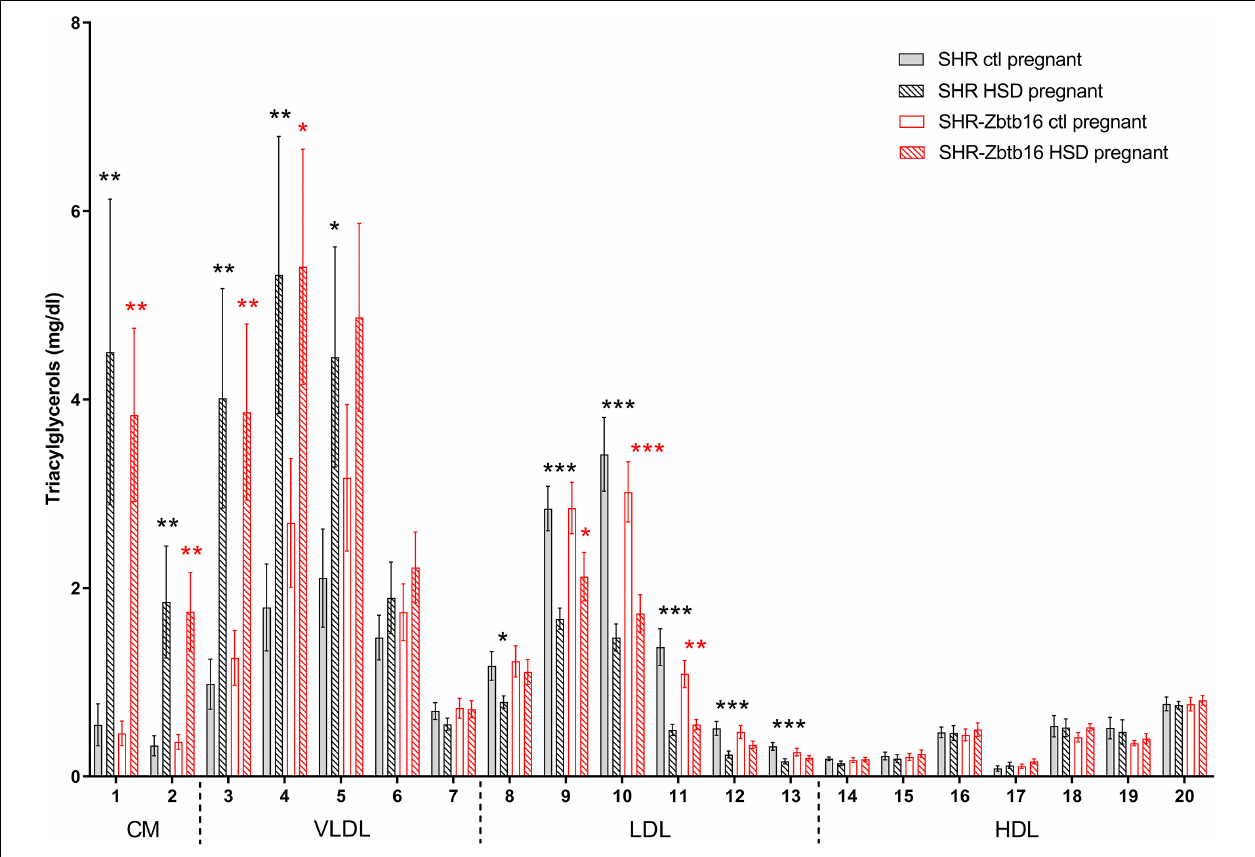
FIGURE 4 | Triacylglycerol profile. The triacylglycerol (Tg) content in 20 lipoprotein subfractions in pregnant SHR female rats and SHR- Zbtb16 female rats – SHR fed standard diet in pregnancy (SHR ctl pregnant – light gray bars), SHR fed HSD in pregnancy (SHR HSD pregnant – black patterned bars), SHR- Zbtb16 fed standard diet in pregnancy (SHR- Zbtb16 ctl pregnant – open red bars) and SHR- Zbtb16 fed HSD in pregnancy (SHR- Zbtb16 HSD pregnant – patterned red bars). Tg profile before pregnancy is shown in Supplementary Material . Within the graph and this legend, the significance levels of pair-wise comparisons (ctl pregnant vs. HSD pregnant) by post-hoc Fisher’s test of the two-way ANOVA with STRAIN and DIET as major factors are indicated as follows: * p < 0.05, ** p < 0.01, *** p < 0.001. Black asterisks mark significance levels between SHR ctl pregnant and SHR HSD pregnant, red asterisks mark significance levels between SHR- Zbtb16 ctl pregnant and SHR- Zbtb16 HSD pregnant. The allocation of individual lipoprotein subfractions to major lipoprotein classes is shown in order of particle’s decreasing size from left to right. CM, chylomicron; VLDL, very low density lipoprotein; LDL, low density lipoprotein; HDL, high density